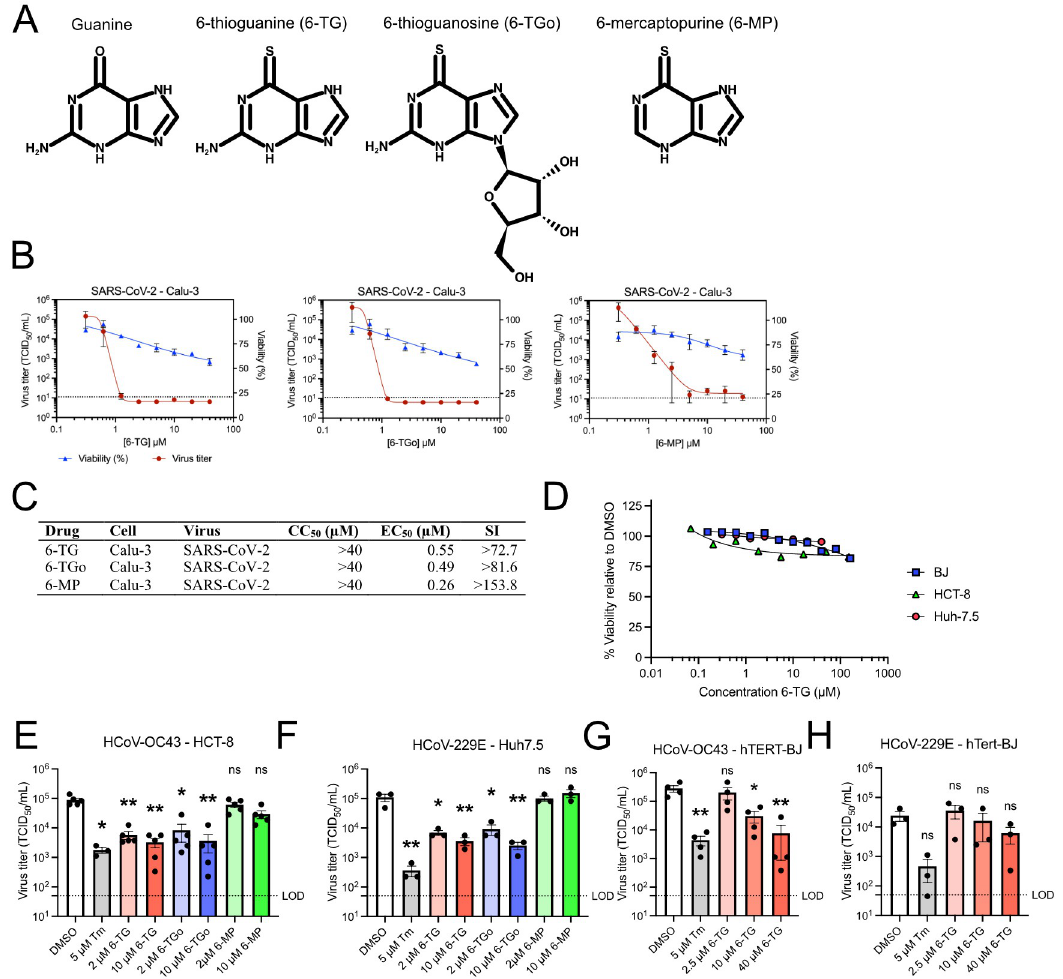
Fig 1. Thiopurines 6-thioguanine and 6-thioguanosine inhibit coronavirus replication. (A) Structures of thiopurines used this study in comparison to guanine. (B) Calu-3 cells were infected with SARS-CoV-2 at an MOI of 0.1 then treated with 6-thioguanine (6-TG), 6-thioguanosine (6-TGo), or 6-mercaptopurine (6-MP). Supernatants were harvested after 48 h and stored at -80˚C until titering on Vero’76 cells. Mock-infected cells were similarly treated with 6-TG, 6-TGo, 6-MP, or DMSO vehicle control for 48 h before testing cell viability with CellTiter 96 AQueous One (n = 3 ± SEM). Dotted line indicates Limit of Detection. (C) Summary table of 50% Cytoxic Concentration (CC 50 ), 50% Effective Concentration (EC 50 ), and Selectivity Index (SI) calculated for (A-C). (D) AlamarBlue cell viability assay of hTert-BJ, HCT-8, and Huh-7.5 cells treated with 6-TG (n = 3 ± SEM). (E-H) TCID50 assays for (E) HCoV-OC43 infected HCT-8 cells and (F) HCoV-229E infected Huh-7.5 cells. Cells were infected with an MOI of 0.1 then treated with tunicamycin (Tm), 6-TG, 6-TGo, 6-MP, or DMSO (n � 3 ± SEM, statistical significance was determined by one-way ANOVA). hTERT-BJ cells were infected with HCoV-OC43 (G) or HCoV-229E (H) at an MOI of 0.1 and treated with 6-TG, Tm, or DMSO. Supernatants were harvested after 23 h and stored at -80˚C before titering on BHK-21 or Huh7.5 (n = 3–4 ± SEM, statistical significance was determined by one-way ANOVA). LOD = Limit of Detection for virus titer. ( � , p < 0.05; �� , p < 0.01; ns, non-